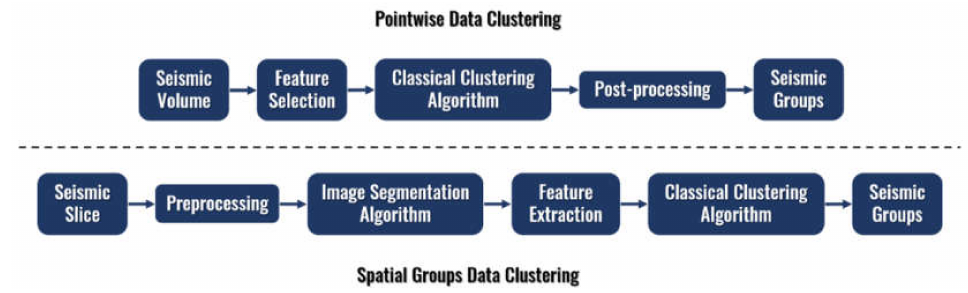
Figure 2. Proposed seismic data clustering